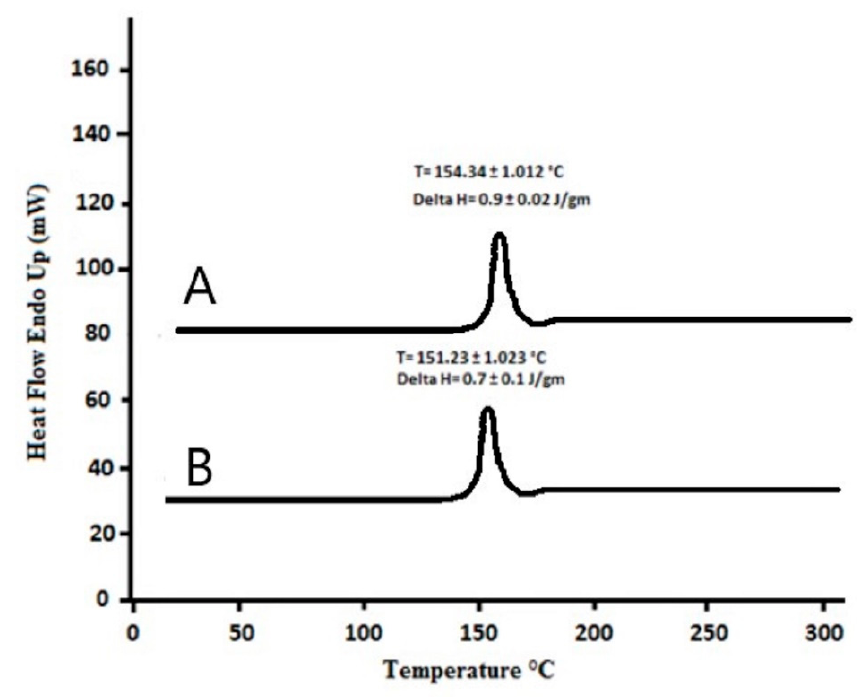
Figure 1. DSC thermogram of (A) pure KA and (B) KA-loaded nanocrystals (F3).